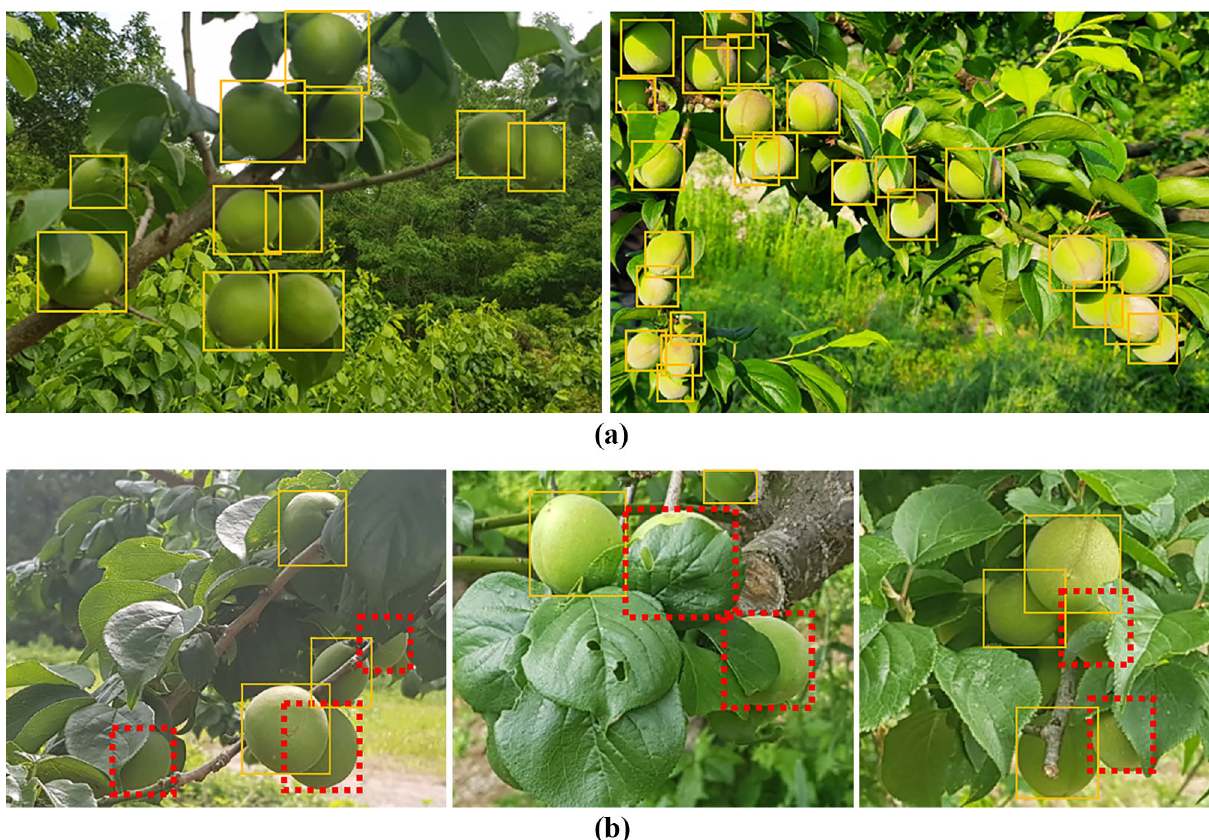
Figure 8. Annotations depending on different conditions: ( a ) Images with small occluded objects with no blurring; ( b ) Images with objects occluded more than 50% (red box, not annotated).